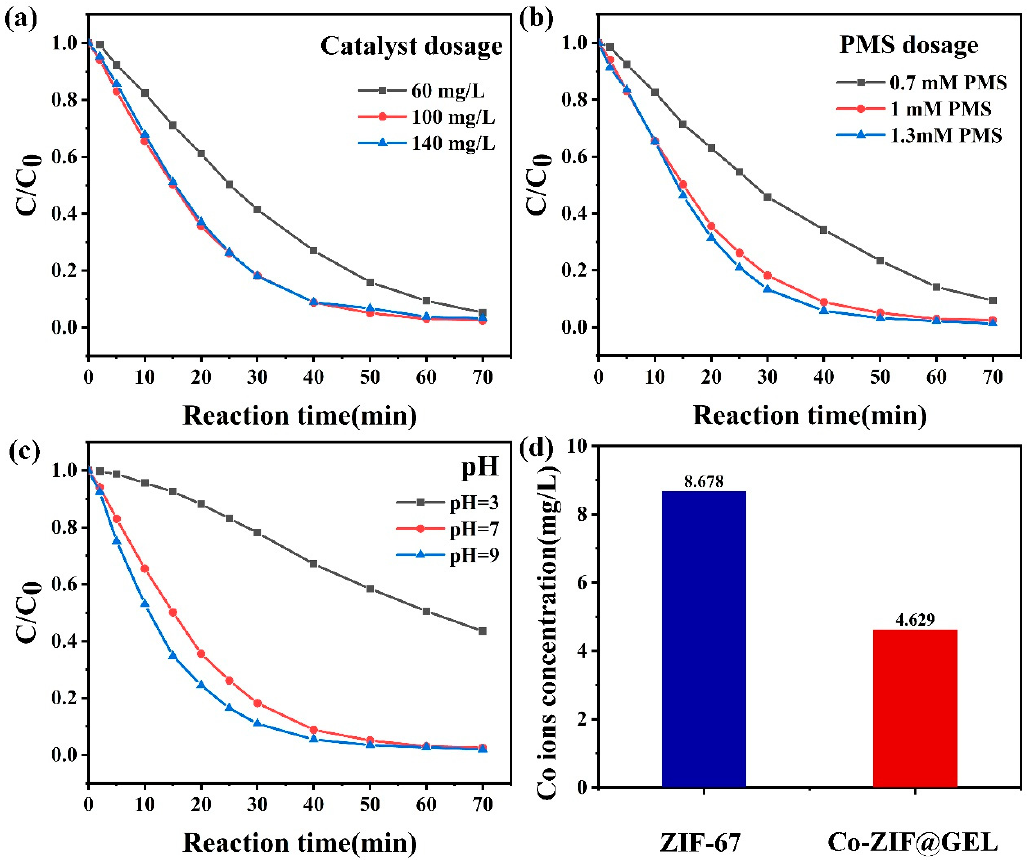
Figure 5. ( a ) The amount of catalyst (PMS = 1 mM) ( b ) The influence of PMS concentration (catalyst = 100 mg/L) on the degradation of PNP ( c ) The influence of initial pH on the reaction ( d ) The dissolution of cobalt ion after the reaction Contrast (conditions: ZIF-67 = 50 mg/L, Co-ZIF@GEL = 100 mg/L, PMS = 1 mM, PNP = 10 mg/L, T = 25 ℃ ;).